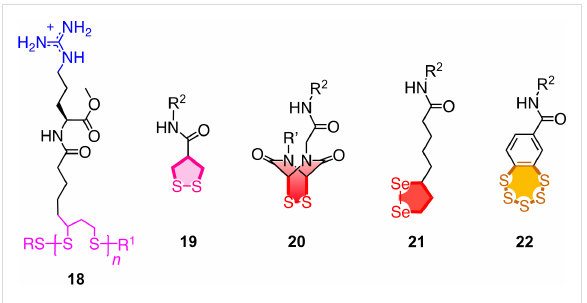
Figure 4: Evolution from CPPs to CPDs and